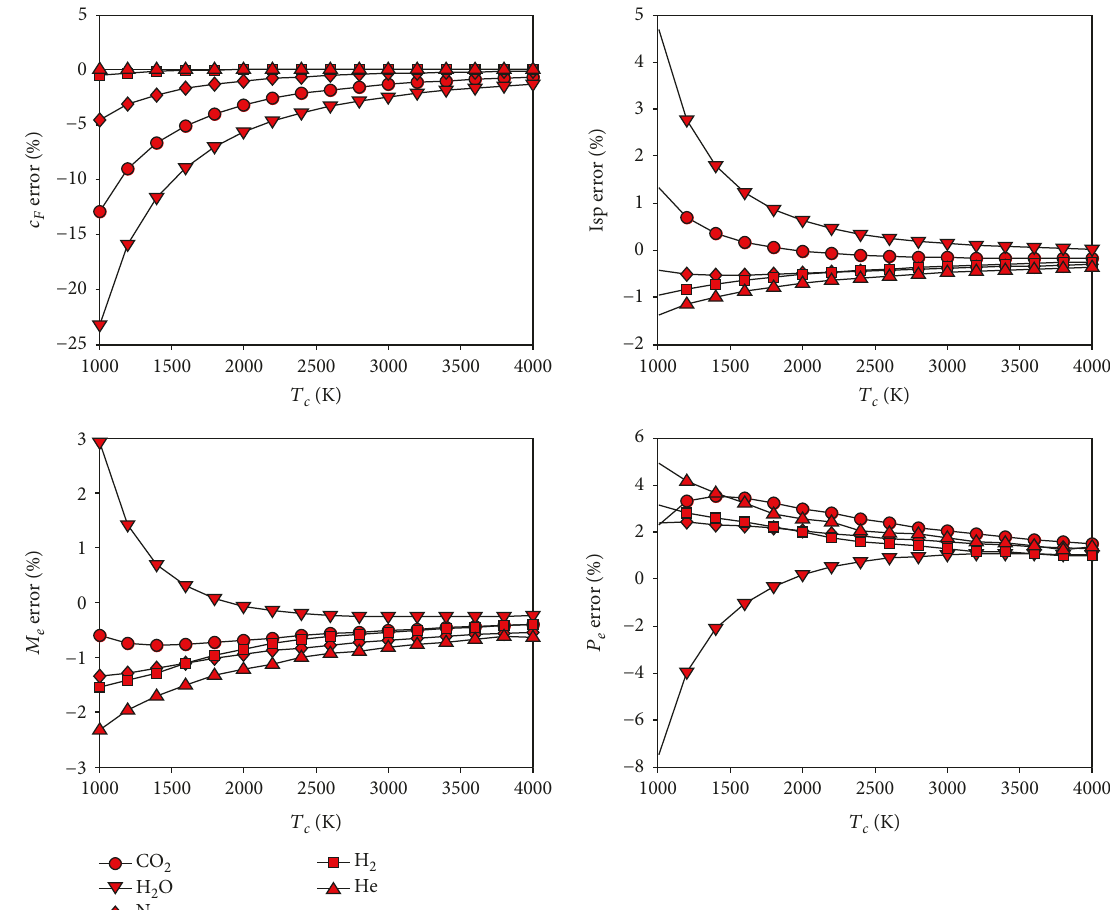
Figure 5: Errors of propulsion parameters and fl ow parameters of thermally perfect ideal gases with respect to VDW gases at di ff erent chamber temperatures, for vacuum expansion, A